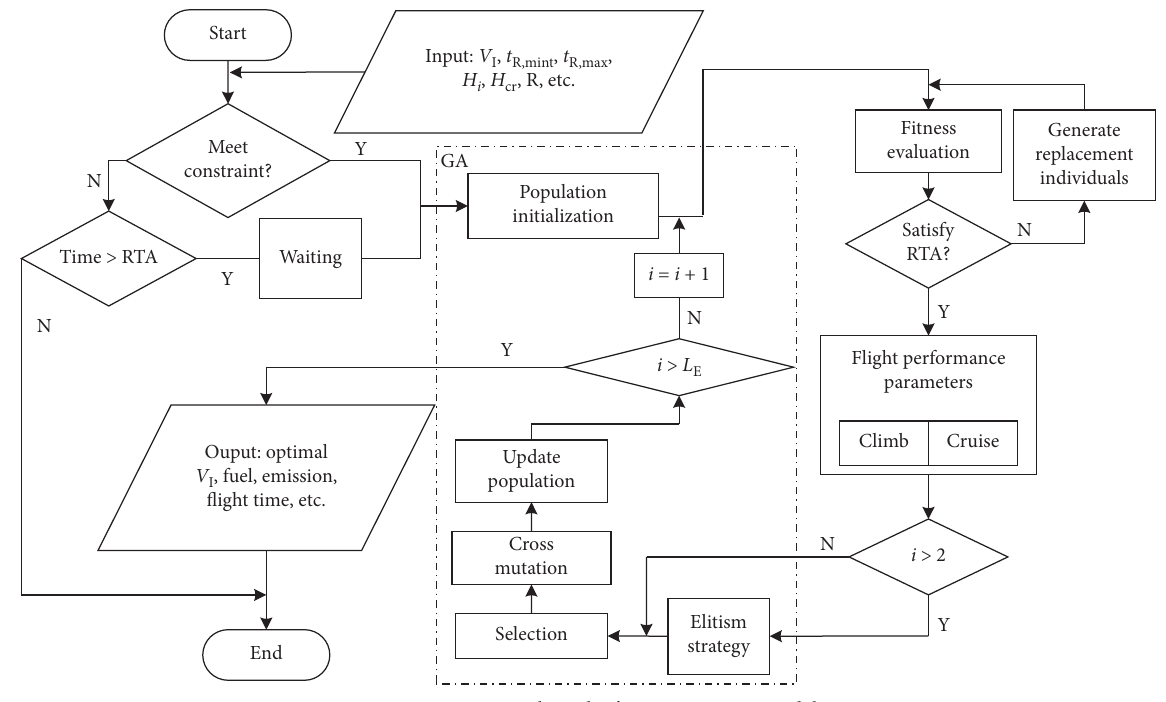
Figure 5: Genetic algorithm’s optimization model.